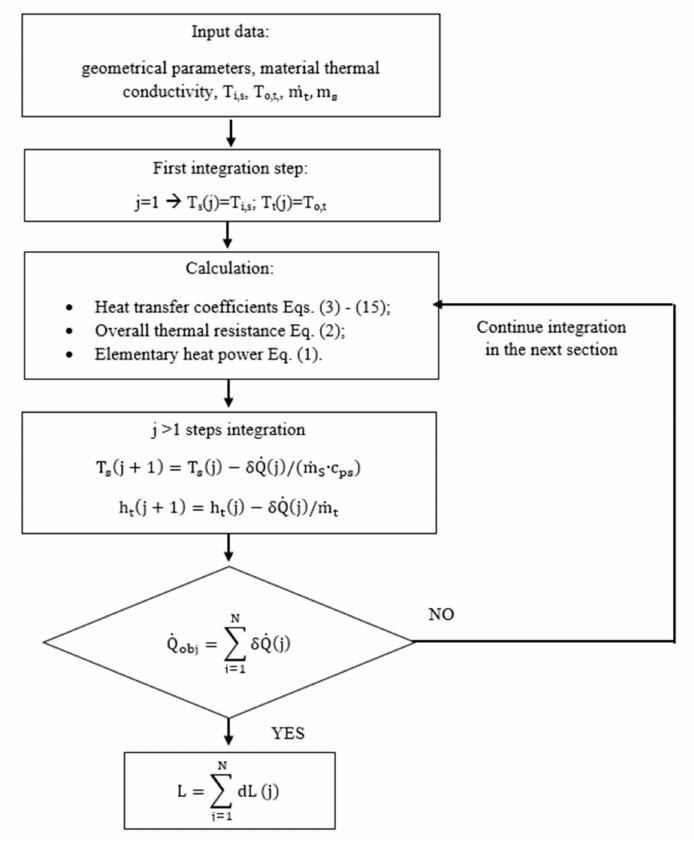
Figure 3. Flow chart of numerical algorithm. Table 3. ORC nominal data [63].